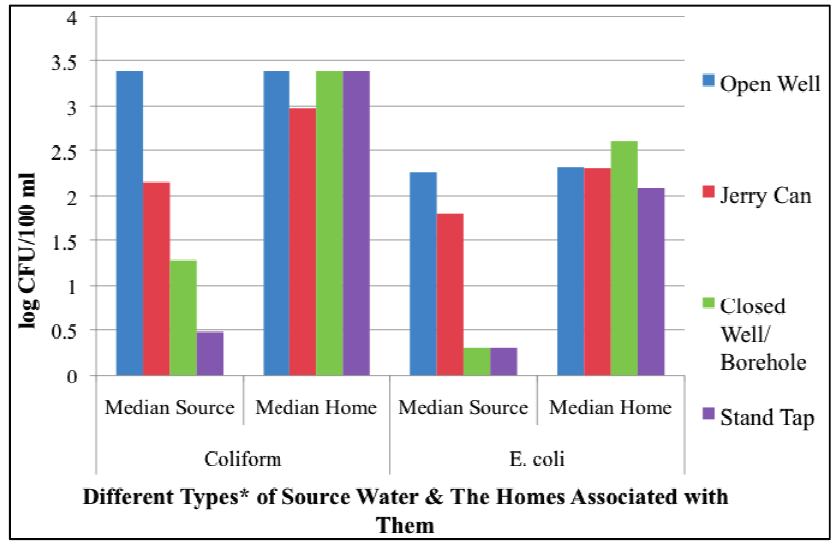
Figure 3. Total coliforms and E. coli median concentration values from different types of drinking water sources and home storage